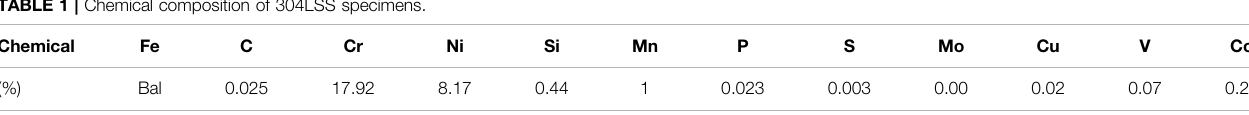
TABLE 1 | Chemical composition of 304LSS specimens.